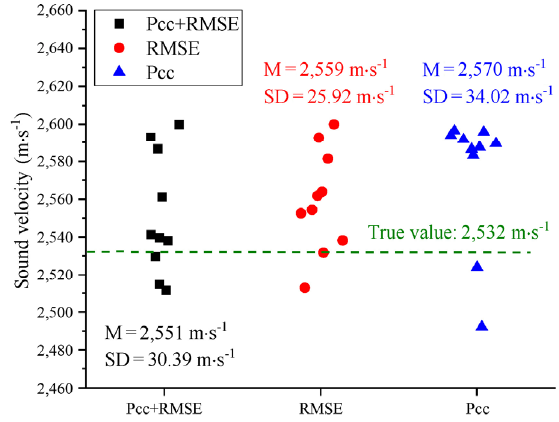
Fig. 10 Effect of different objective functions on the inversion results of density.